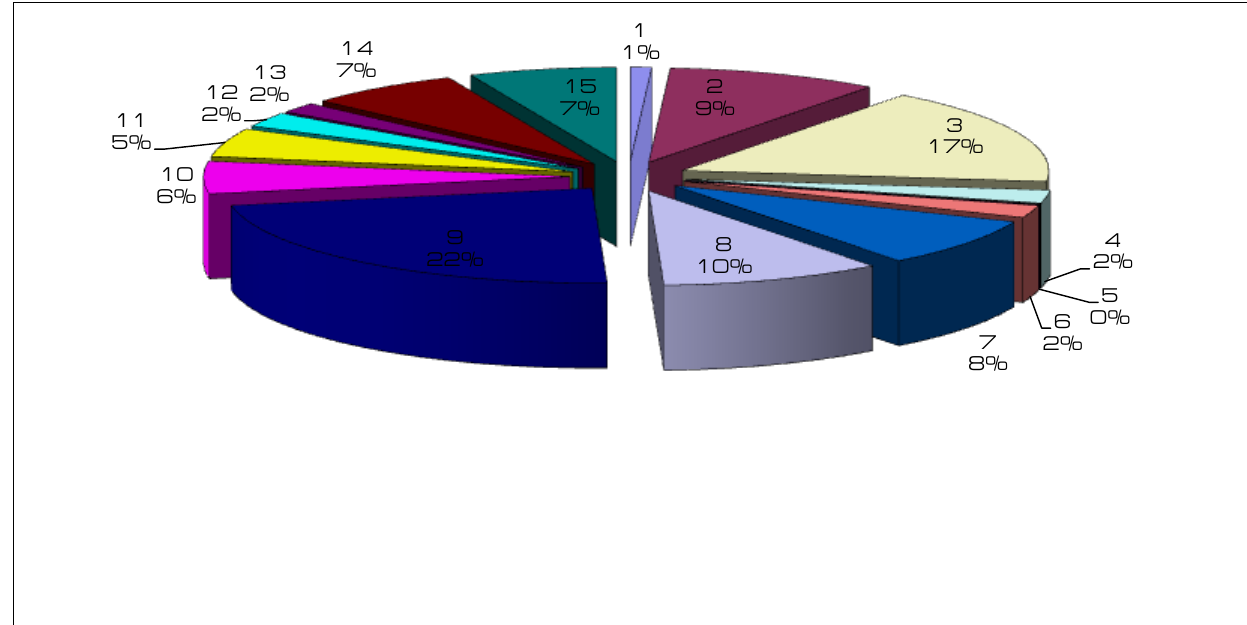
Fig.3. Diagram of significance of anatomic-morphological indicators for central zone